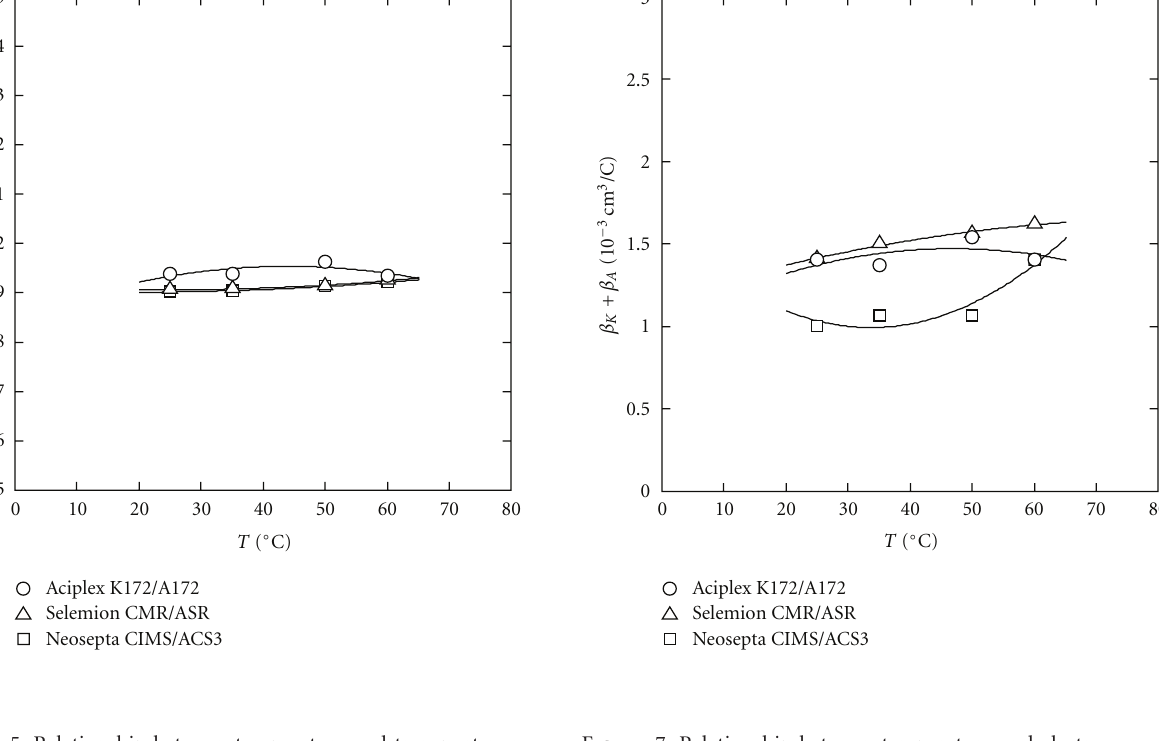
Figure 7: Relationship between temperature and electro-osmotic permeability.